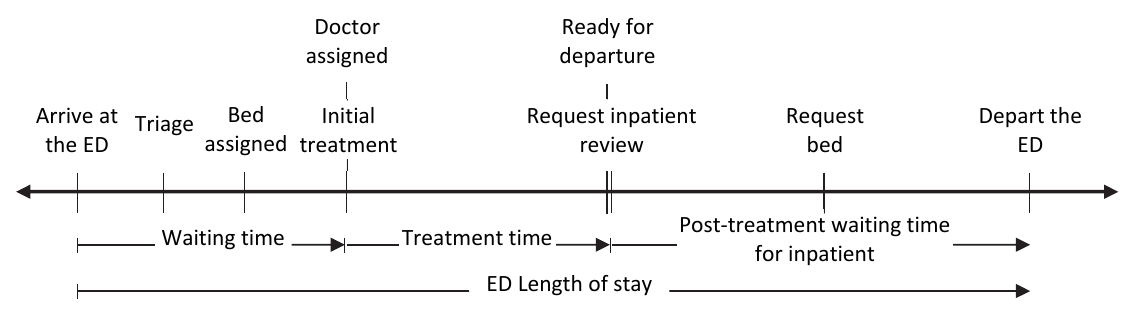
Fig. 1. ED patient workflow and definitions of important time spans